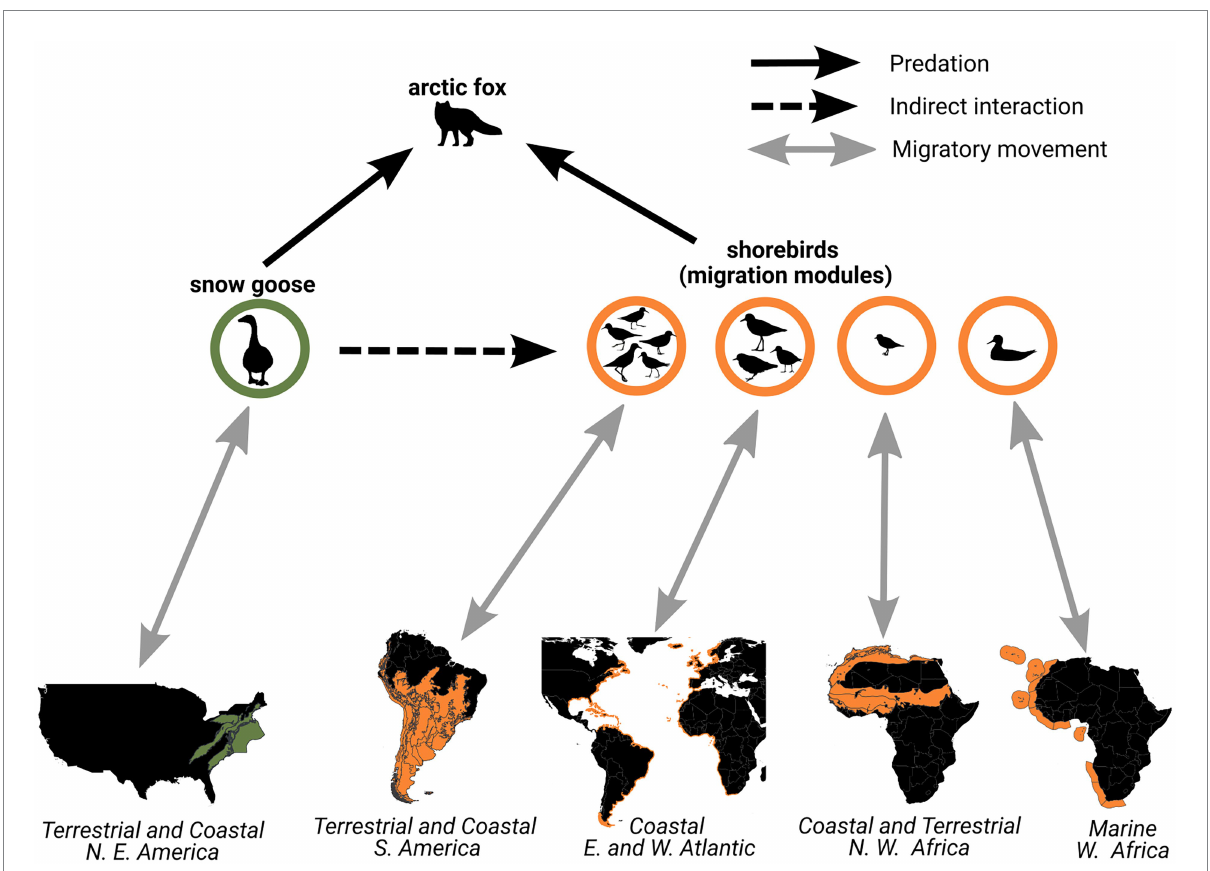
FIGURE 7 Snow geese and shorebirds breeding on Bylot Island share a predator (Arctic fox), which may result in the spatial propagation of agricultural changes occurring in temperate ecoregions used by geese during the non-breeding period (green) to ecoregions used by shorebirds during the non-breeding period (orange). The functional group of shorebirds is divided into four circles representing the modules in the community migration network and the extent of their associated ecoregions is shown on the maps. Negative indirect effects of geese on shorebirds could also pass-through overgrazing on the breeding grounds, which reduces nest site quality or